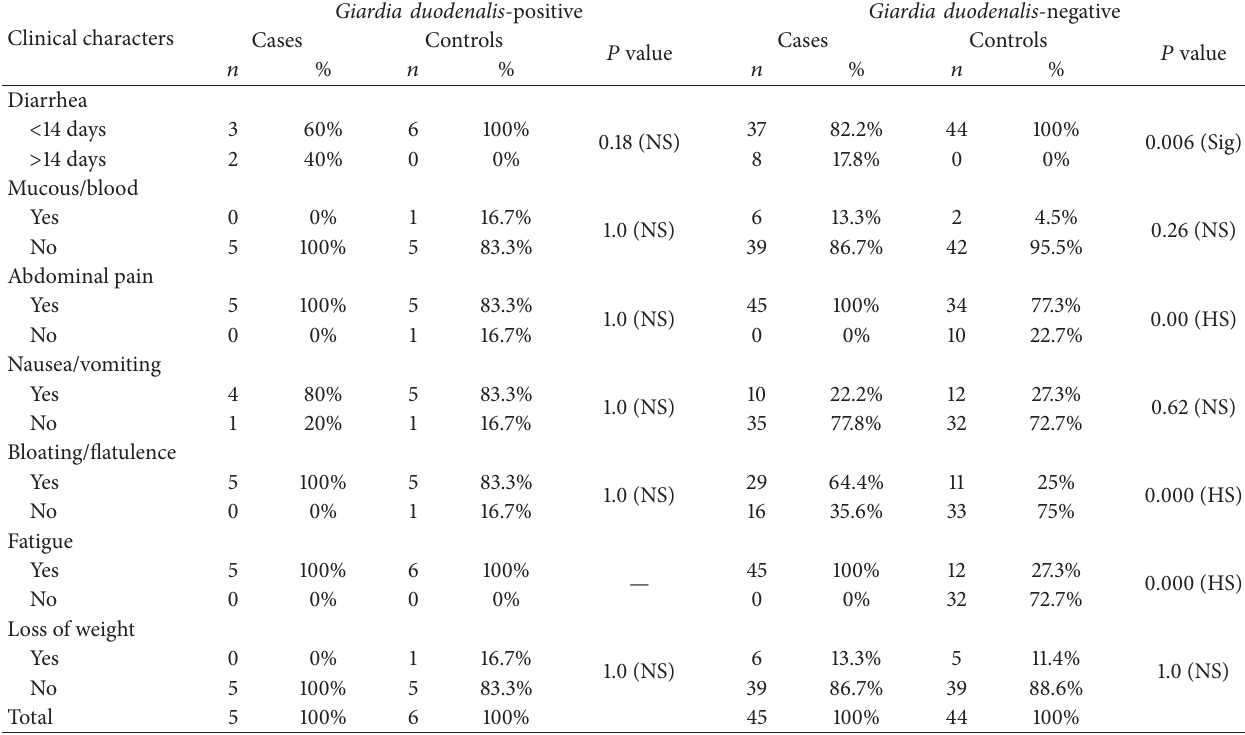
Table 5: The clinical characteristics variations among Giardia duodenalis positive/negative diarrheal cases and controls. Clinical